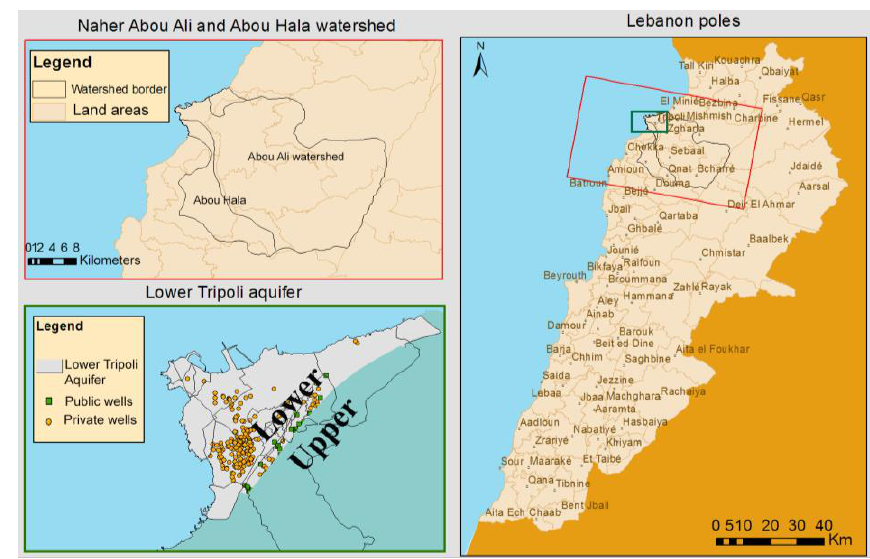
Figure 1. Location map of rivers, watersheds, study area, and well positions, after Kalaoun et al. (2016) [12].